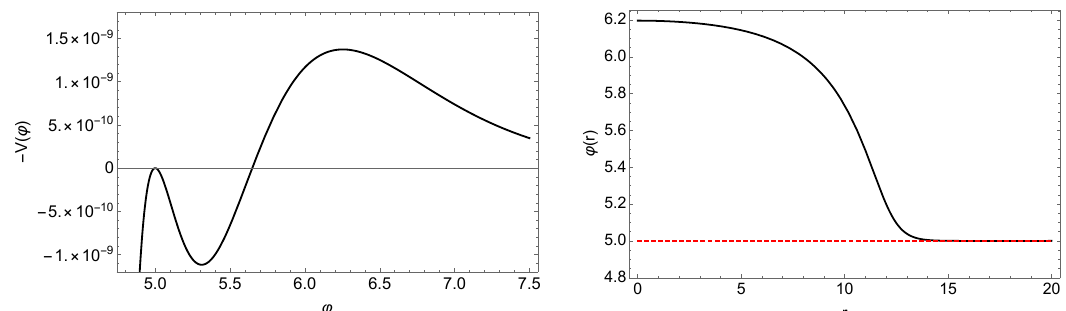
Figure 6 . Left panel : inverted potential in the case ! = 0 : 025. The two minima become two maxima and the bounce solution corresponds to the classical motion of a point particle that starts close to the larger maximum and stops exactly in the lower maximum. The e(cid:11)ective mass com- puted around the fake minimum in ’ ’ 5 : 3 sets the timescale for such classical motion and hence also the natural spatial scale for the radius of the bounce solution plotted in the right panel. Right panel: bounce solution interpolating between the fake AdS vacuum and the Minkowski vac- uum of the modi(cid:12)ed potential for ! = 0 : 025. The red dashed line represents the position of the Minkowski